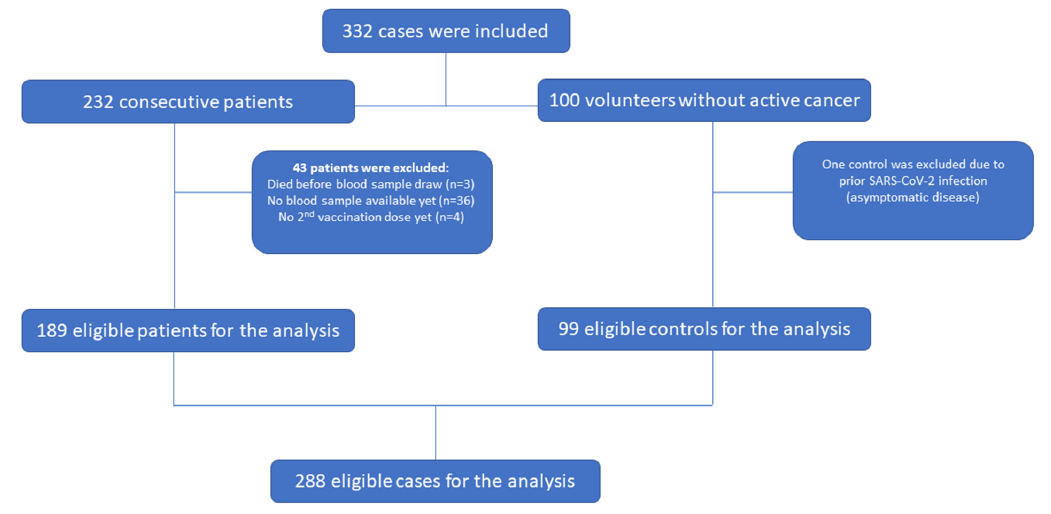
Table 1. Baseline characteristics for patients and